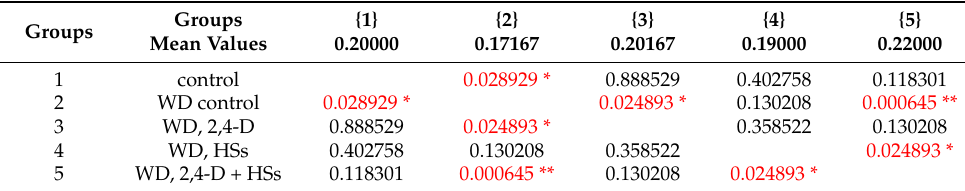
Table 4. ANOVA test for root mass followed by Duncan test. Values in the cells correspond to p for the difference between the mean values; p ≤ 0.05 is marked with *; p ≤ 0.01—with ** for control plants untreated with either bacteria or HSs and plants grown under water deficit (WD): control, plants treated with Pseudomonas plecoglossicida 2,4-D (2,4-D), humic substances (HSs) and their combinations (2,4-D + HSs).